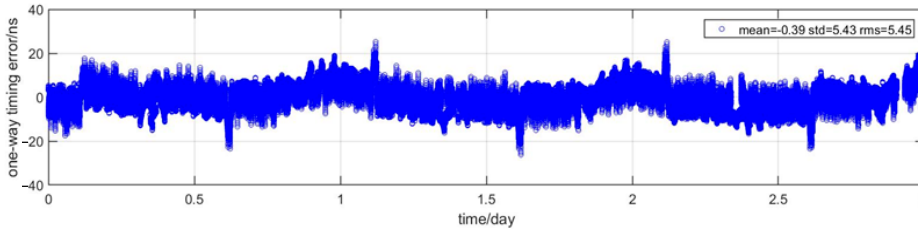
Figure 3. RDSS one-way time service error (normal state).